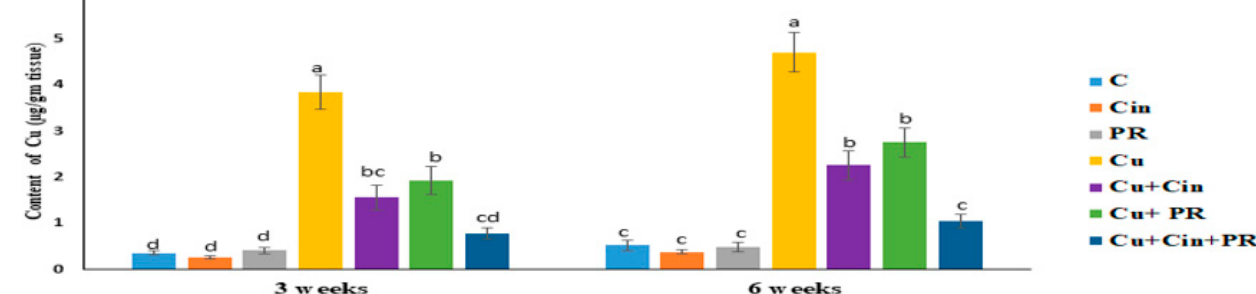
Figure 2. Concentrations of copper in renal tissues of chickens following treatment with cinnamon (200 mg/kg diet), probiotic (1 g/4 L drinking water), and CuSO 4 (300 mg/kg diet) either individually or concurrently for 3 weeks or 6 weeks. Data are presented as mean ± SEM ( n = 5 chickens). Each bar carrying different letters is significantly different ( p < 0.05). C, control; Cin, cinnamon extract; PR, probiotic; Cu, copper.